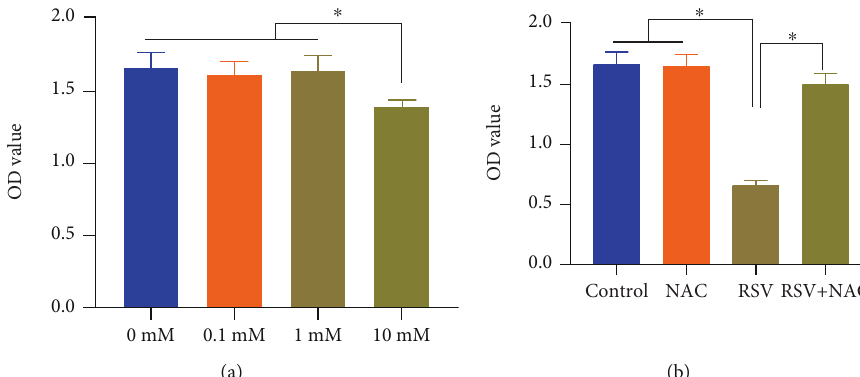
Figure 1: NAC treatment protects BEAS-2B cell survival against RSV infection. (a) BEAS-2B cells were exposed to NAC at 0, 0.1, 1, and 10mM concentrations for 24h, and CCK-8 assays were performed to assess the cytotoxicity of NAC to BEAS-2B cells. (b) CCK-8 assays were performed to examine in RSV-infected BEAS-2B cells with or without 1mM NAC treatment. ∗ indicates p < 0 : 05 .